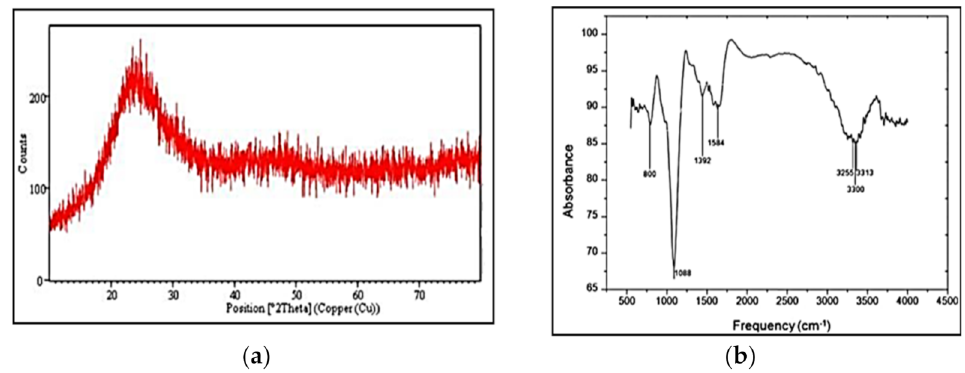
Figure 27. ( a ) XRD pattern of rice husk biochar and ( b ) FTIR of rice husk biochar